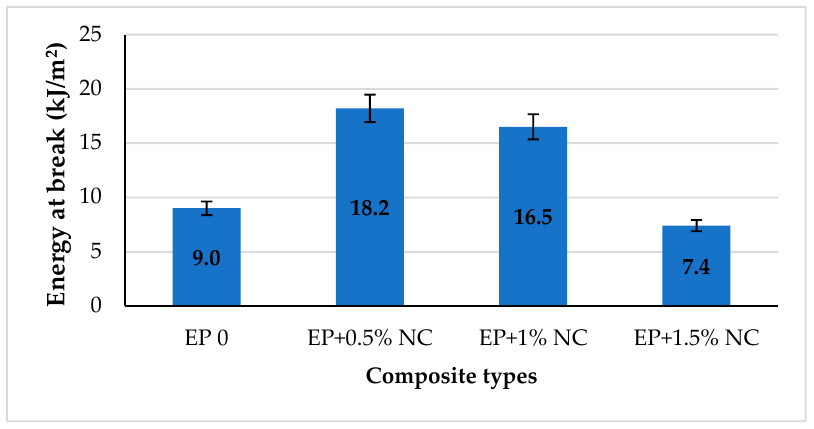
Figure 10. The energy at break for epoxy composites with NC.